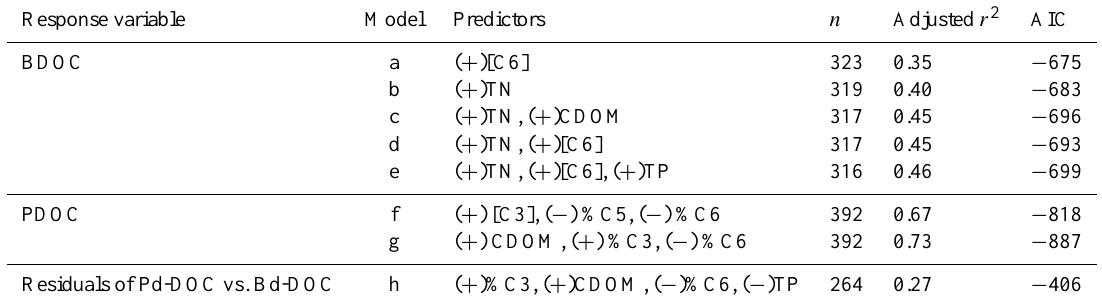
Table 1. Multiple linear regression models predicting the concentrations of photochemically and biologically degradable DOC across boreal lakes, rivers and wetlands. Abbreviations are defined in the text. Fluorescence components in square brackets correspond to the absolute concentration of the specified component. The sign in parentheses denotes the sign of the coefficient in the MLR model. Response variable